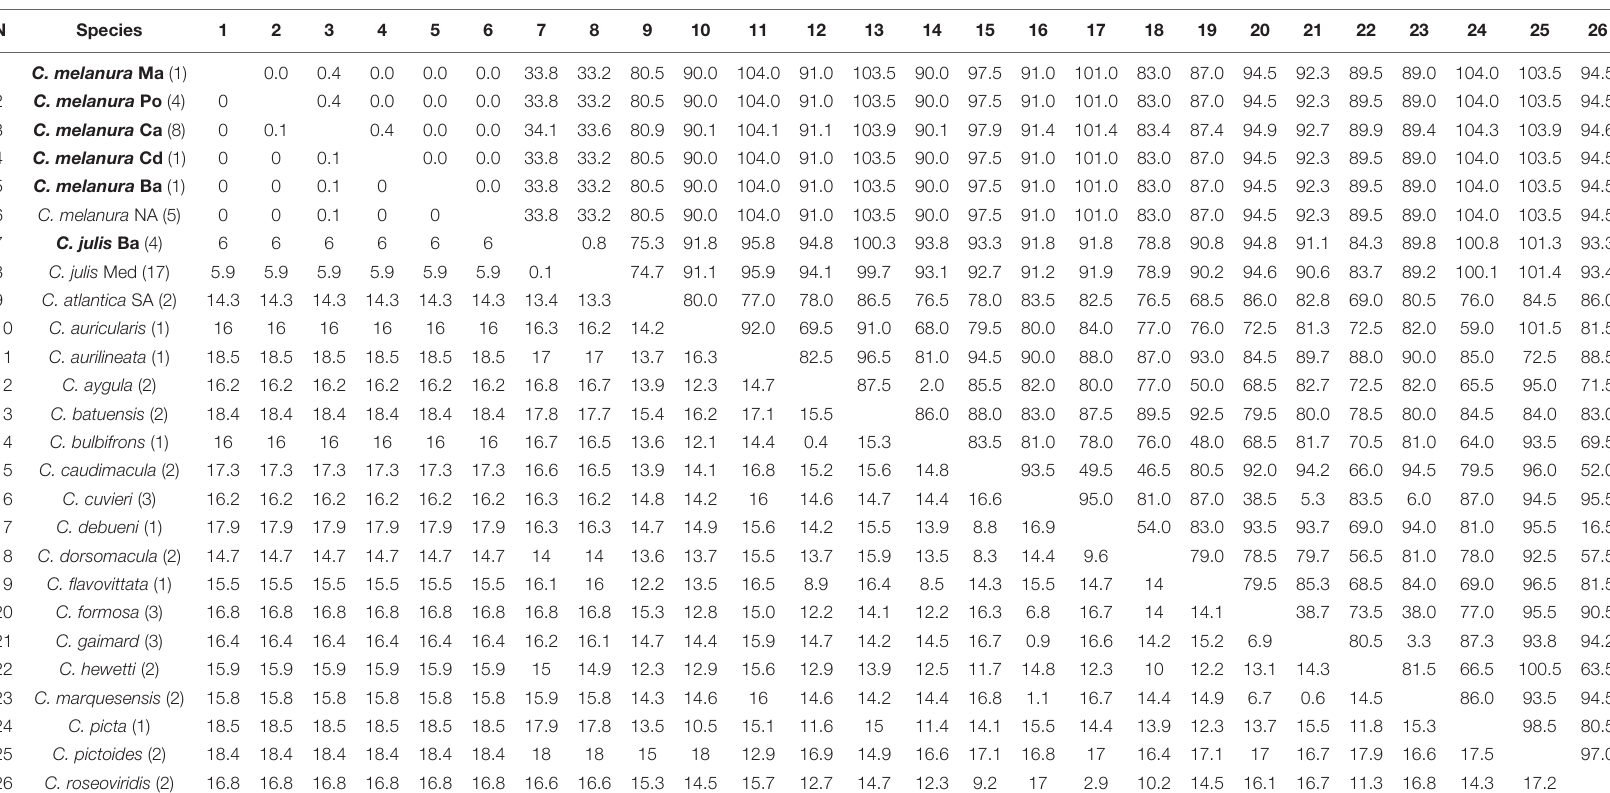
TABLE 5 | Mean genetic distances (%) and numbers of base differences for COI from Coris species below and above the diagonal,